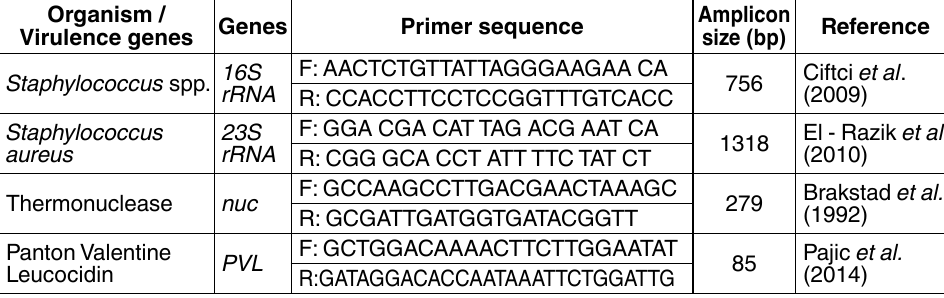
table 1. Details of primers used in PCR